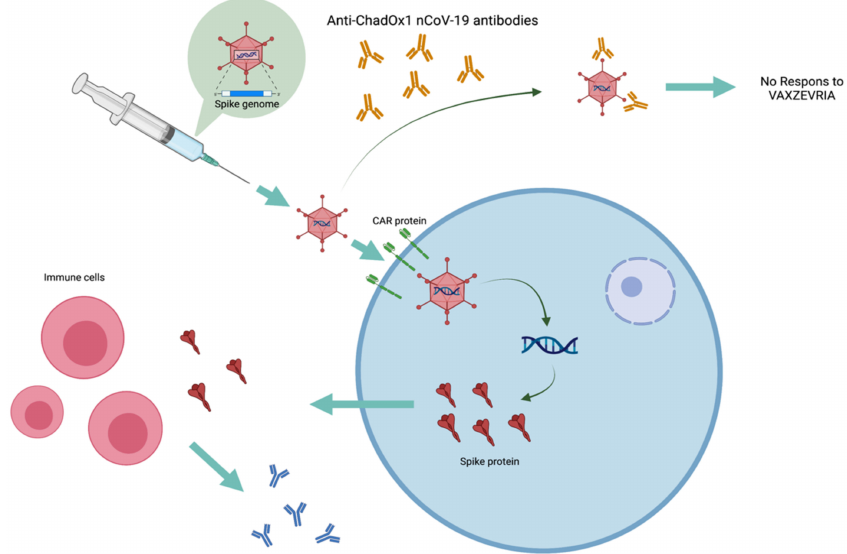
Figure 1. The schema of the mechanism of action of the Vaxzevria ® vaccine and the consequences of prior immunization against ChadOx1 nCoV-19. In this figure the different stages of the response to Vaxzevria ® vaccine can be distinguished. This response starts with the injection and interaction of ChADOx1 nCoV-19 with cells expressing the CAR protein. This is followed by an intracellular process leading to the production and secretion of protein S. This S-protein outside the cells will be recognized by the immune system allowing the production of anti-S antibodies. In the case of pre-existing immunity to ChADOx1 nCoV-19, the antibodies present will prevent interaction with cells expressing the CAR protein, leading to a lack of response to the Vaxzevria ® vaccine.